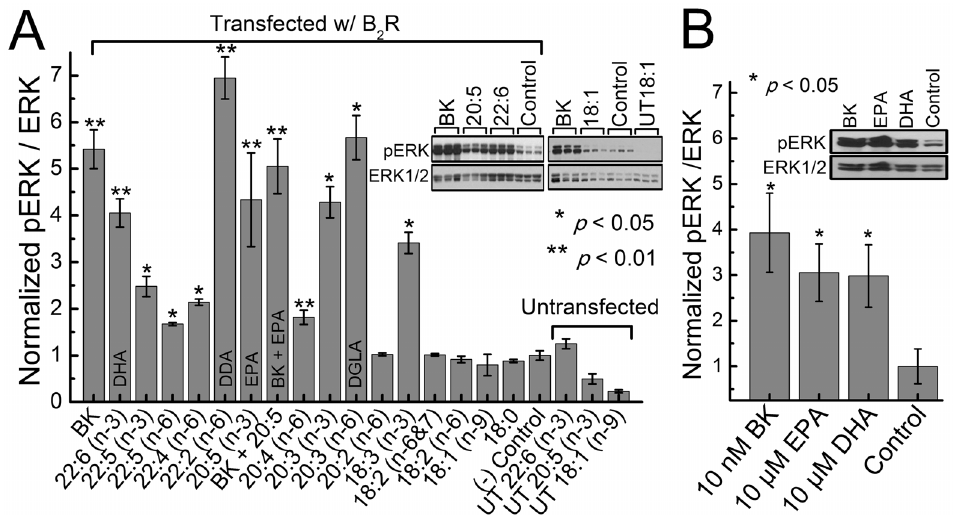
Figure 2. Activation of B 2 R by fatty acids in HEK293 cells. BK concentration in (A) was 100 nM (positive control) and (B) was 10 nM. Fatty acid concentrations were 10 m M in HEK293 cells transfected with B 2 R as described under Materials & Methods and treated for (A) 5 minutes or (B) 15 seconds in PBS at 37 u C. Western blots were used to determine ERK1/2 phosphorylation. Data represent mean of n $ 6 experiments. Error bars indicate standard error of the mean